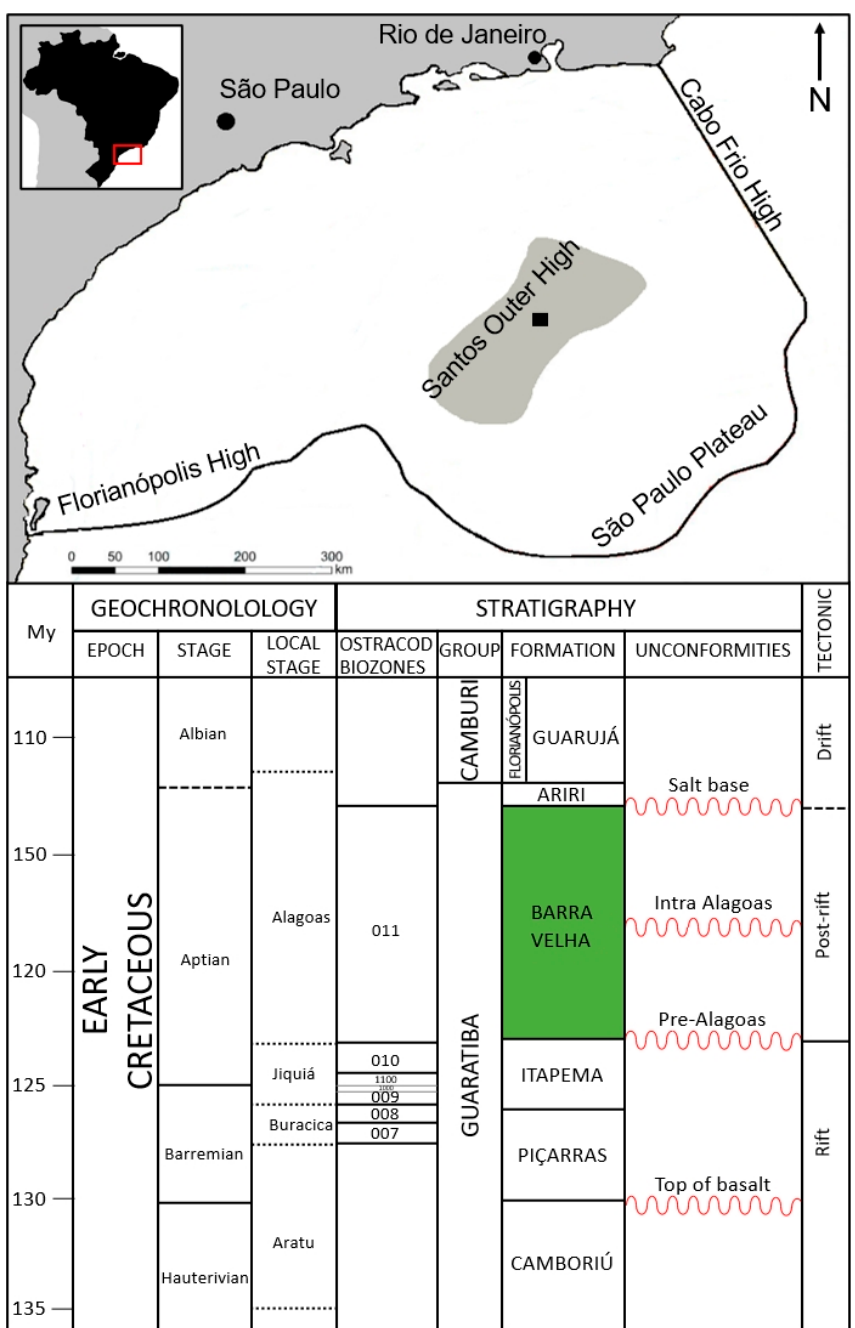
Figure 1. Location of the Santos Basin, offshore Brazil. The black rectangle into the Santos Outer High shows the studying area (modified from [20]). The Lower Cretaceous stratigraphic chart is also shown. The boundaries of Barra Velha Fm are given by Pre-Alagoas Unconformity and Salt Base Unconformity. The Barra Velha Fm is separated into lower and upper by the Intra-Alagoas Unconformity. The Barra Velha Fm was deposited during the Alagoas Local Stage, which is correlated to the Ostracod Biozone 011 [21] (modified from Netto et al. [2]).